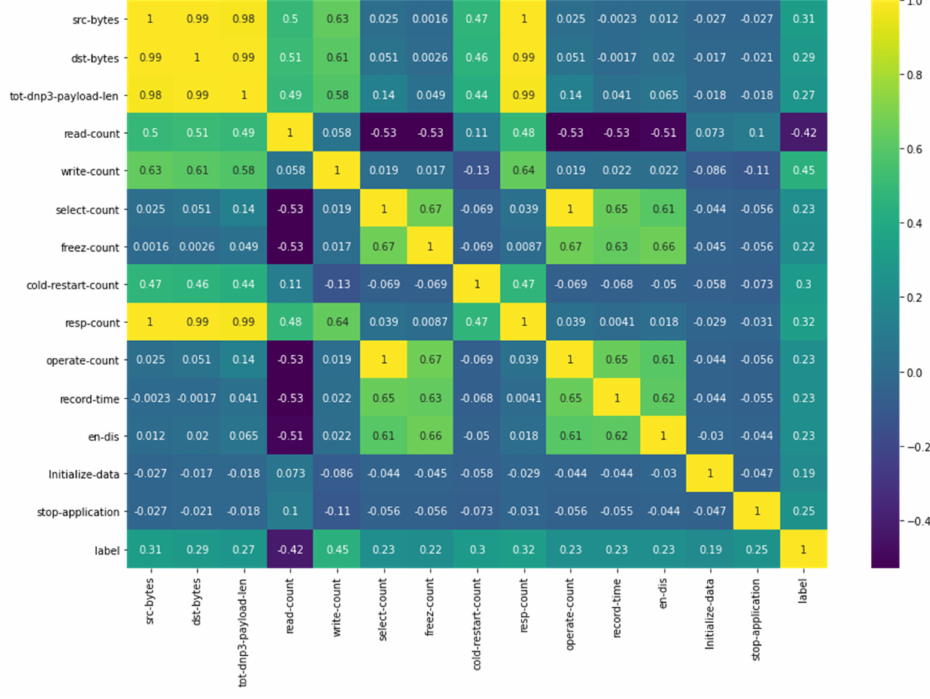
Figure 6. Correlation between input